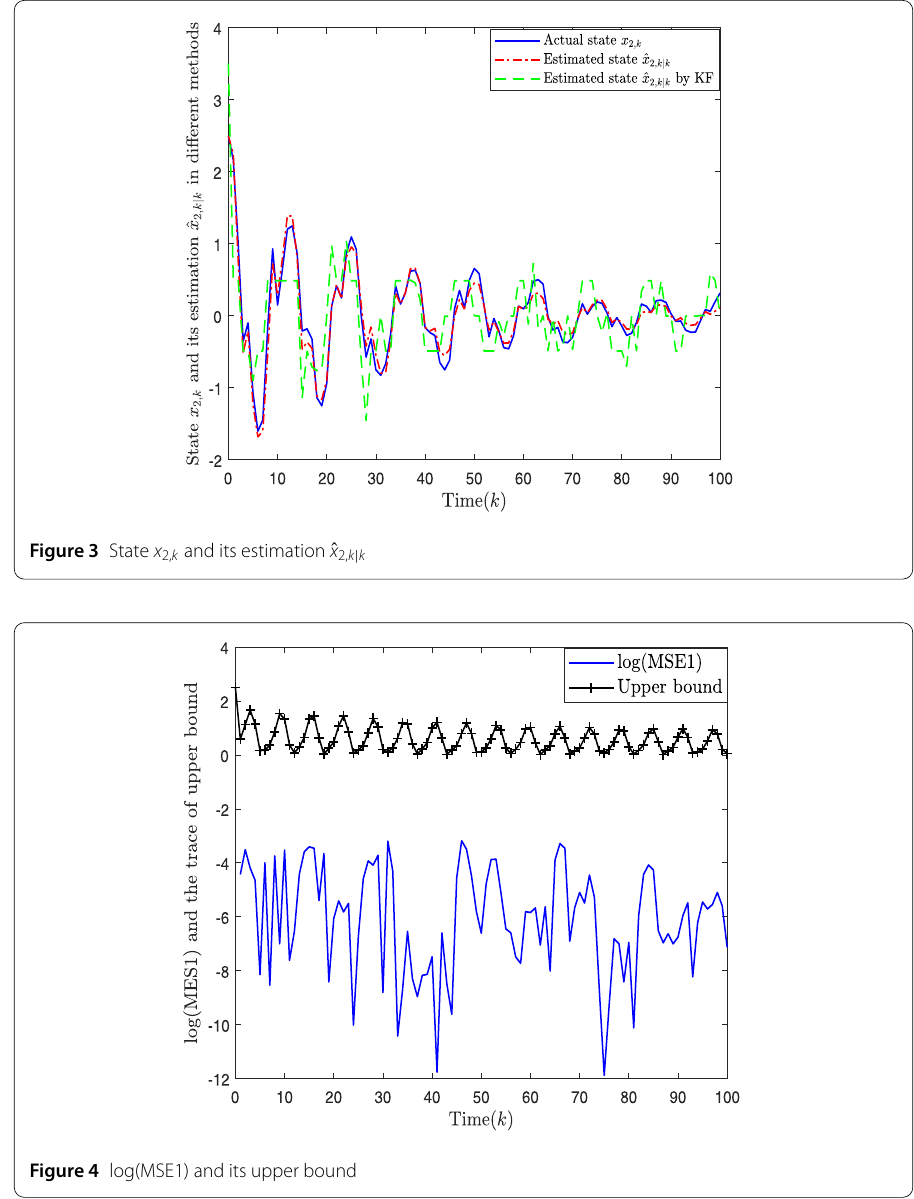
The parameters of the logarithmic quantizer are chosen u 1 parameters are given by ε 1 = 0.01, ε 2 = 1, ε 3 = 0.1, ε 4 = 0.01, ε 5 = 0.01, ε 6 = 1, γ k +1,1 = 0.68, ¯ Λ ¯ α k = 0.59 and k = 0.35. From (18)–(19), we can obtain the filter gain at each